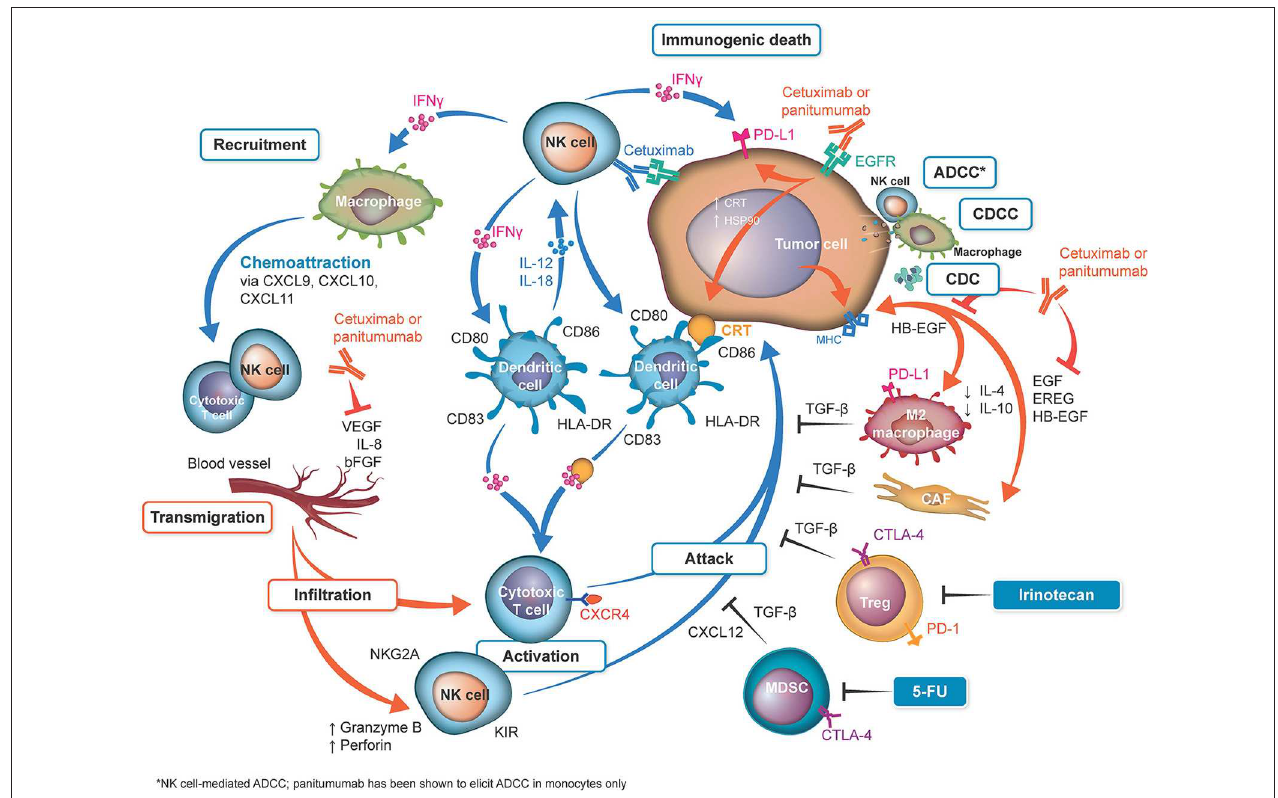
FIGURE 1 | Overview of differences in immune activation with cetuximab and panitumumab. Shown in orange: sites of activation by both anti–epidermal growth factor receptor (EGFR) monoclonal antibodies (mAbs). Both anti-EGFR mAbs neutralize the cross talk between the cancer cells and M2 monocytes and cancer-associated fibroblasts (CAFs) by neutralization of EGFR ligands. On the basis that cetuximab and panitumumab may have identical effects, from a mechanistic point of view, both antibodies reduce vascular endothelial growth factor (VEGF) production (20, 21). Cetuximab can upregulate calreticulin (CRT), heat shock protein (HSP) 90, and major histocompatibility complex (MHC) (22, 23), which may be theoretically upregulated by panitumumab (not reported). Shown in blue: sites activated by cetuximab. Natural killer (NK) cells are activated by their binding to the cetuximab loaded onto EGFR ( 22, 24, 25). The released interferon γ (IFN- γ ) activates dendritic cells (DCs), which further activate the NK cells (26). Cetuximab-induced antibody-dependent cell-mediated cytotoxicity (ADCC), complement-dependent cell-mediated cytotoxicity (CDCC), complement-mediated cytotoxicity (CDC) ( 27–30), and immunogenic death (31) release tumor antigens, which are captured by the activated DC cells, to be presented to T cells (thus activating them). IFN- γ upregulates programmed cell death 1 ligand 1 (PD-L1) on tumor cells and activates macrophages to release chemoattraction substances for NK cells and T cells ( 25). Inhibition of the angiogenic factors VEGF, interleukin (IL) 8, and fibroblast growth factor (FGF) can be downregulated by both cetuximab and possibly by panitumumab ( 20, 21). Inhibition of these factors upregulates key homing adhesion molecules for the immune cells (intercellular adhesion molecule 1 [ICAM-1] and vascular cell adhesion protein 1 [VCAM-1]) (32, 33) and downregulates Fas antigen ligand (FasL) expression ( 34), which would be lethal for T cells. These effects enable the safe transmigration of T cells and NK cells into the tumor microenvironment (35). The T cells activated by DCs loaded with tumor cell antigens are then ready to attack the tumor cells. Shown in black : Immune suppressive mechanisms/prevention of the successful attack of activated cytotoxic T cells on tumor cells. These mechanisms include checkpoint inhibitory factors (programmed cell death 1 protein [PD-1], PD-L1, cytotoxic T-lymphocyte protein 4 [CTLA-4]) and TGF- β generated by tumor-associated cells (25). Notably, irinotecan and fluorouracil (5-FU) can eliminate tumor protective cells, such as regulatory T cells (Tregs) and myeloid-derived suppressor cells (MDSCs), from the tumor microenvironment (36, 37), reducing their immune suppressive effects and thus potentially facilitating the T-cell attack. bFGF, basic fibroblast growth factor; EREG, epiregulin;